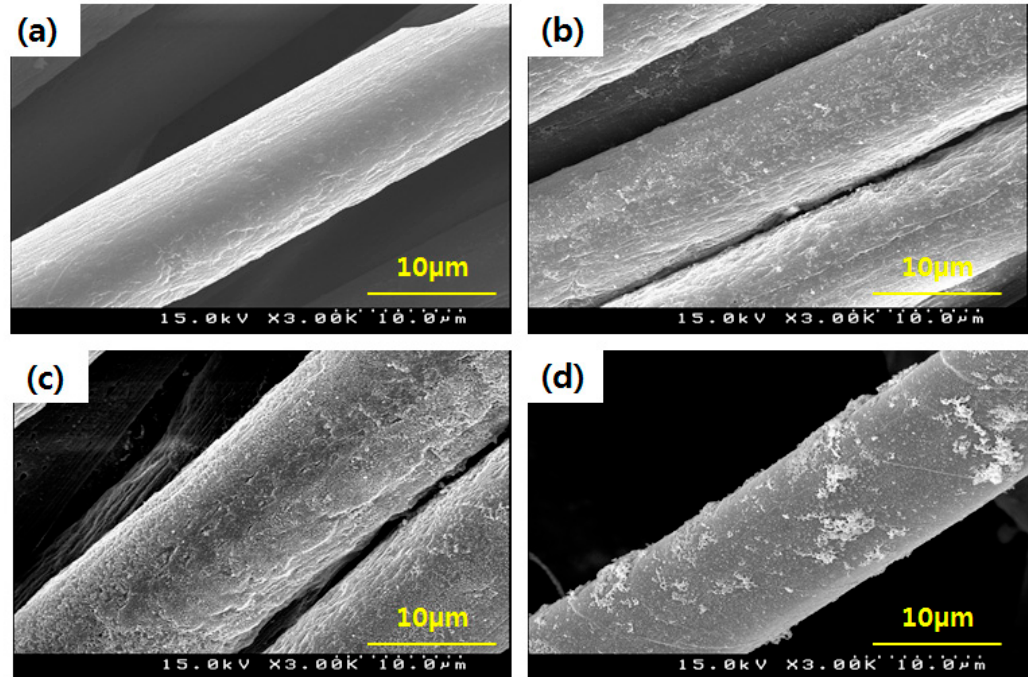
Figure 2. Scanning electron microscopy (SEM) micrograph of ( a ) untreated p -aramid fiber and ( b ) treated p -aramid fiber with 10 wt % of GTAC/2500 ppm of AgNPs; ( c ) treated p -aramid fiber with 10 wt % of GTAC/10,000 ppm of AgNPs; and ( d ) treated p -aramid fiber with 10 wt % of GTAC/30,000 ppm of AgNPs.